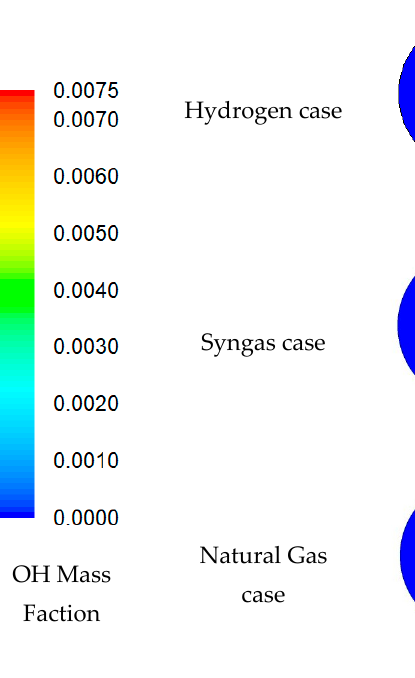
Figure 22. OH distributions in combustor.